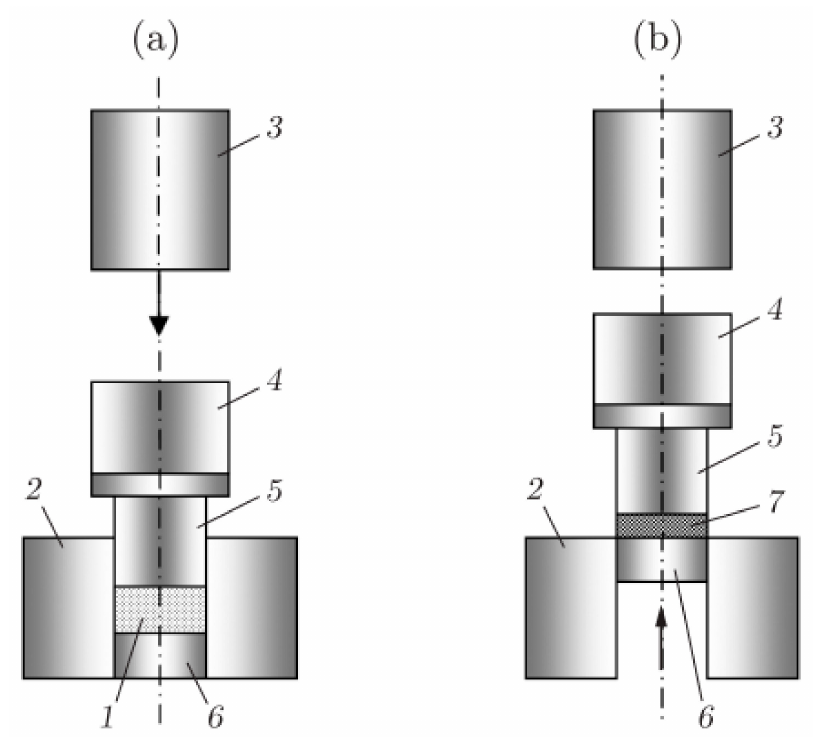
Figure 1. The principle of the CIC method: ( a ) position of the apparatus during compaction; ( b ) position of the apparatus after the end of compaction; (1) pressed powder; (2) die; (3) impactor; (4) spacer; (5) mushroom-shaped piston; (6) ejector; and (7) prepared compact. Reprinted with the permission of the Journal of Applied Mechanics and Technical Physics from [18]. Copyright 2017.